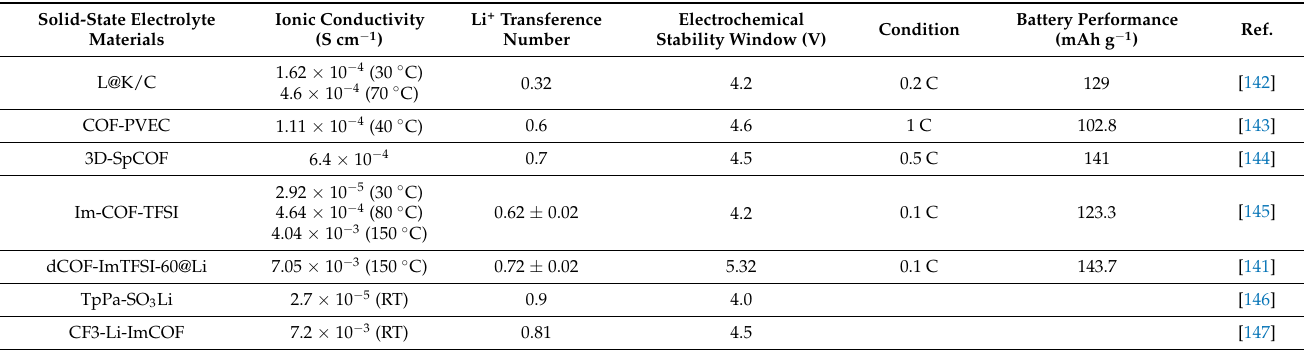
Table 3. Summary of the major performances of COF-based